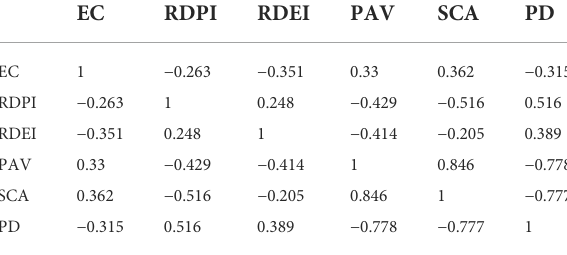
TABLE 3 Correlation coef fi cients between